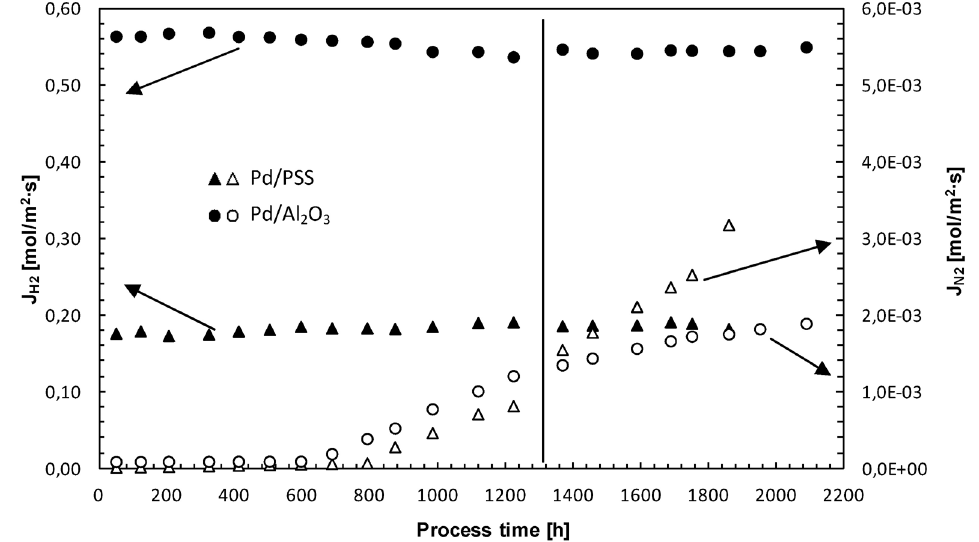
Figure 8. H function of process